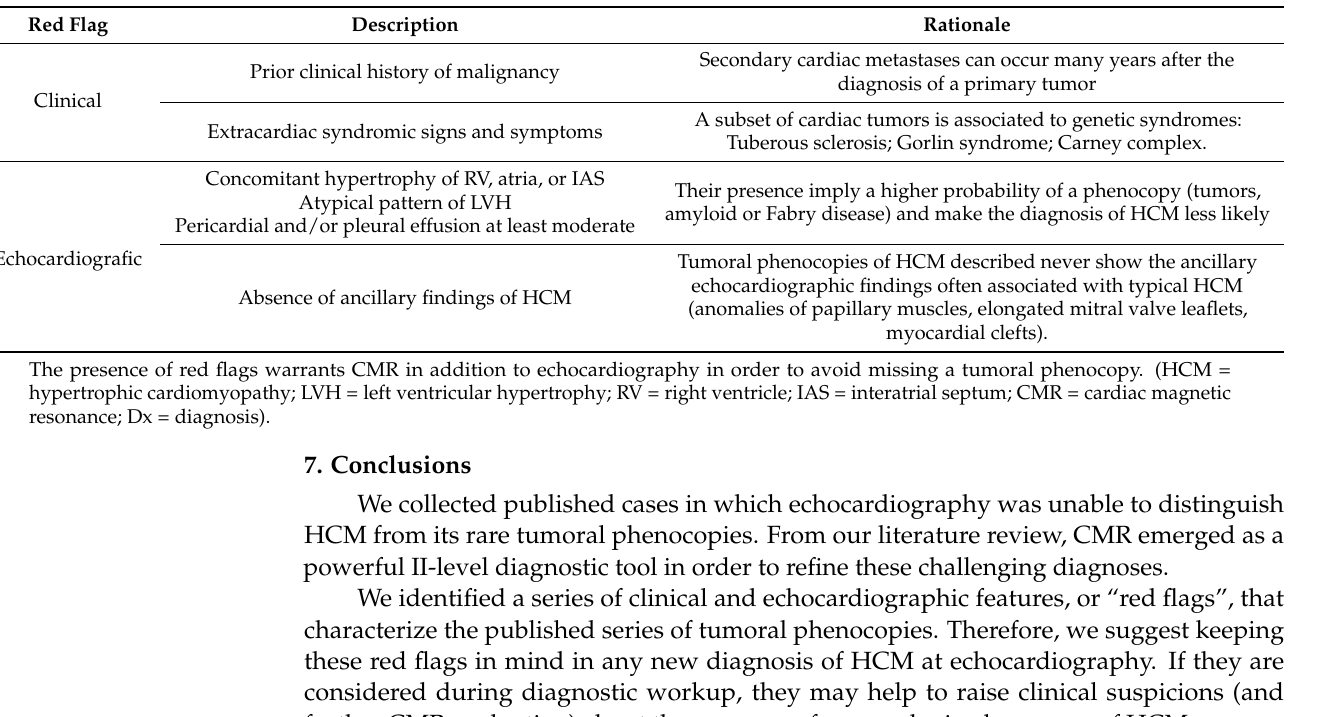
Table 4. Red flags suggesting a possible tumoral phenocopy of